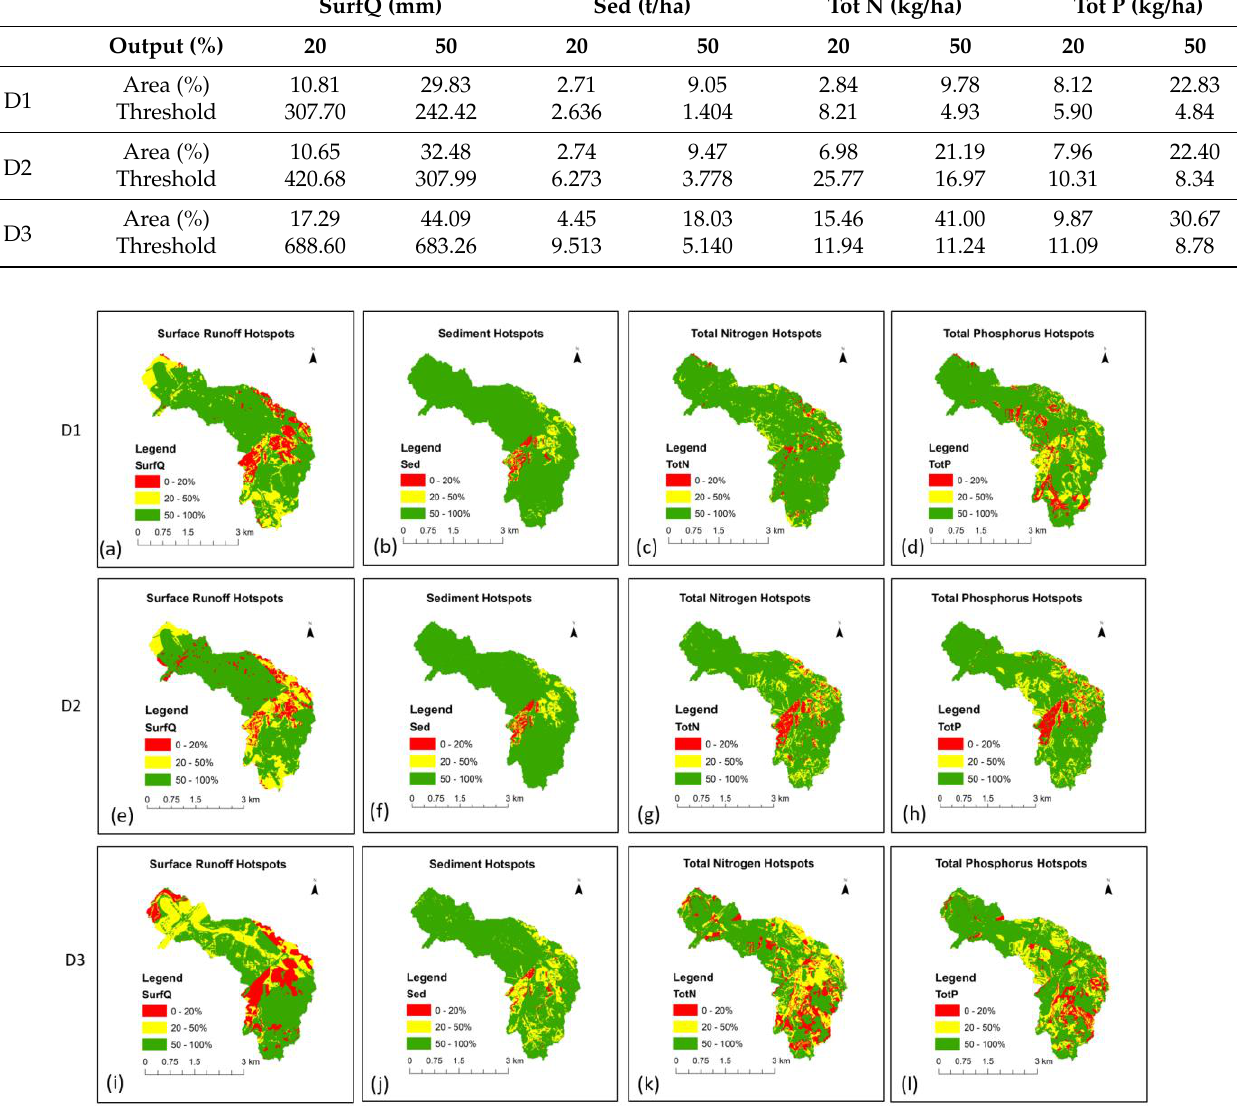
Figure 10. Hotspots for ( a, e, i ) total surface runoff (SurfQ), ( b, f, j ) total sediment (Sed), ( c, g, k ) total nitrogen (Tot N), and ( d, h, l ) total phosphorus (Tot P) in three synthetic watersheds: ( D1 ) synthetic natural watershed, ( D2 ) synthetic agricultural watershed, and ( D3 ) synthetic urban watershed. Red and yellow areas in each map account for 20% and 30% of the total output of each constituent, re- spectively.